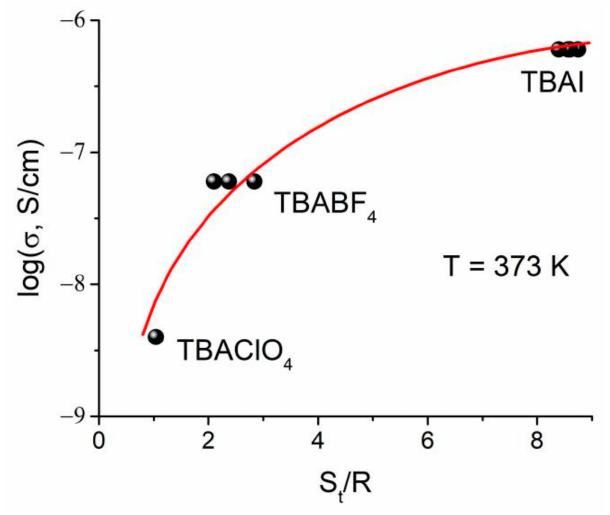
Figure 4. Correlation between the phase transition entropy, S t , and ionic conductivity at 373 K in isostructural HT phases of TBA salts. The line is a